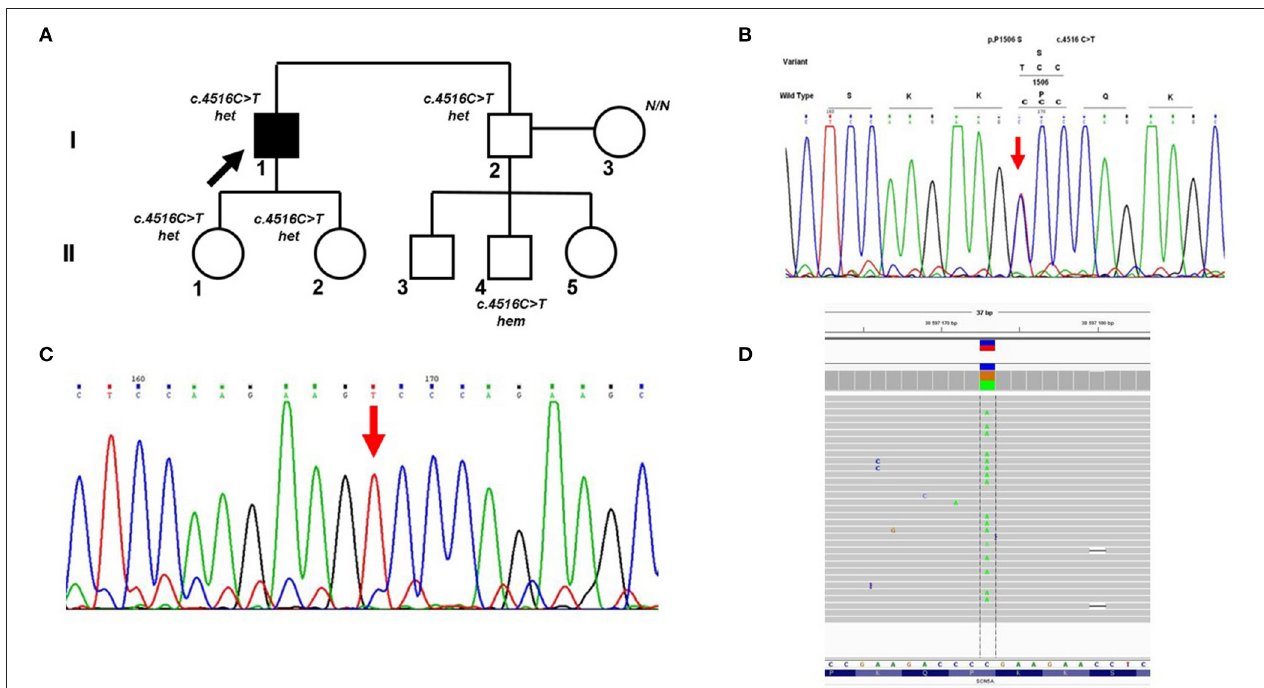
FIGURE 2 | Allelic dropout in the SCN5A gene in family with Brugada syndrome. (A) Pedigree of the family; Arrow marks the proband. Het, heterozygous; hem, hemizygous. (B) Fragment of the Sanger sequencing chromatogram showing the presence of heterozygous variant c.4516C > T in the proband (arrow). (C) Fragment of the Sanger sequencing chromatogram showing the presence of hemizygous variant c.4516C > T in the II-4 family member (arrow). (D) Control re-sequencing on the IonTorrent platform showing the family member II-4 is a carrier of heterozygous variant c.4516C >